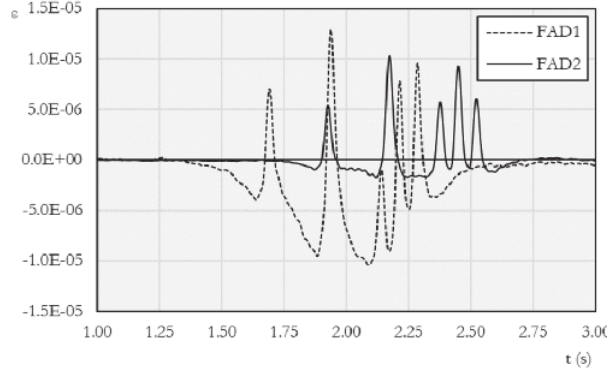
Signals obtained with FAD sensors for a 5-axle